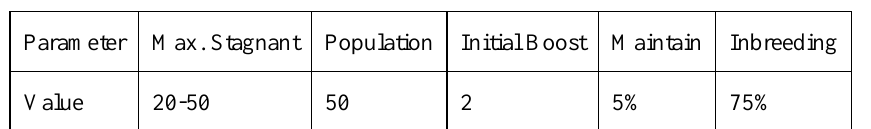
Table 6. The parameters for objective